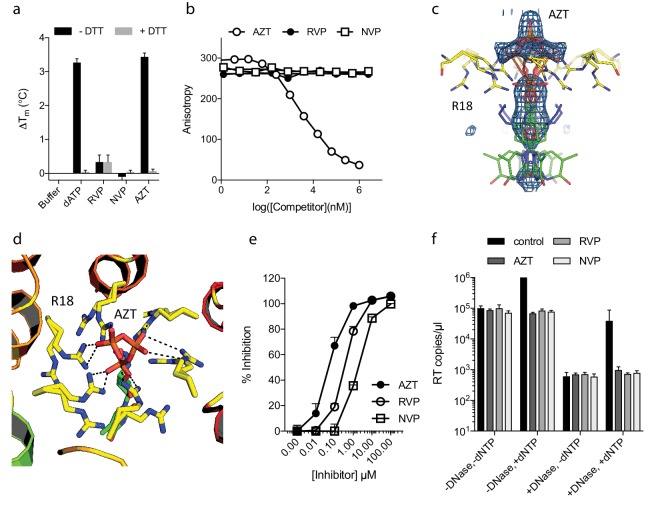
NNRTIs and NRTIs are equally potent ERT inhibitors despite differences in pore binding.(a) Changes in hexamer capsid stability upon incubation with dATP or inhibitors in the presence and absence of DTT. Data are averaged from three replicates and representative of three independent experiments. (b) Fluorescence anisotropy competition binding experiments to hexamer capsid with inhibitors. A decrease in anisotropy indicates the ligand has displaced bound BODIPY-ATP. Averaged data from three measurements is shown and is representative of three independent experiments. (c) Electron density for NRTI AZT in complex with HIV capsid hexamer. (d) Putative hydrogen bonds between AZT and capsid reside R18. R18 adopts multiple side-chain conformations. (e) In vitro inhibition of reverse transcriptase enzyme. Data are mean of three replicates ± SD. (f) ERT experiments in presence of inhibitors at in vitro IC90 concentrations. Data are mean of three replicates ± SD.